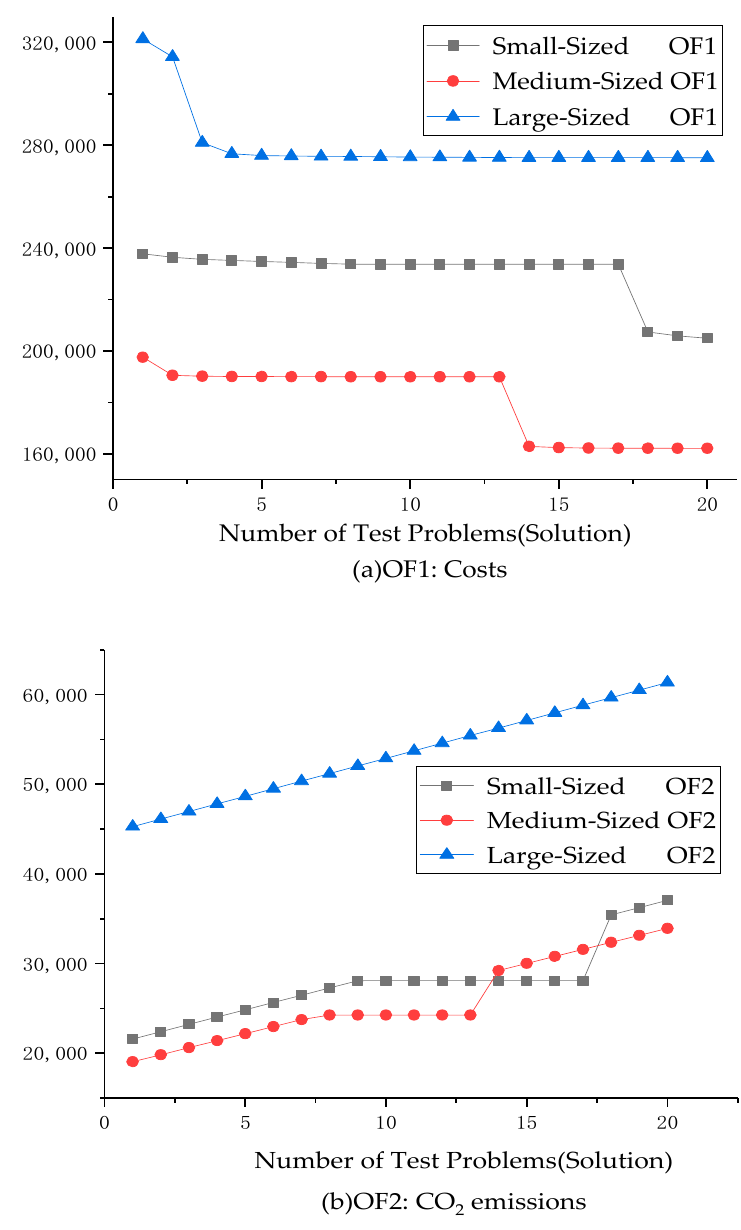
Figure 7. Objective values for three sizes of test problems: ( a ) OF1, ( b ) OF2.